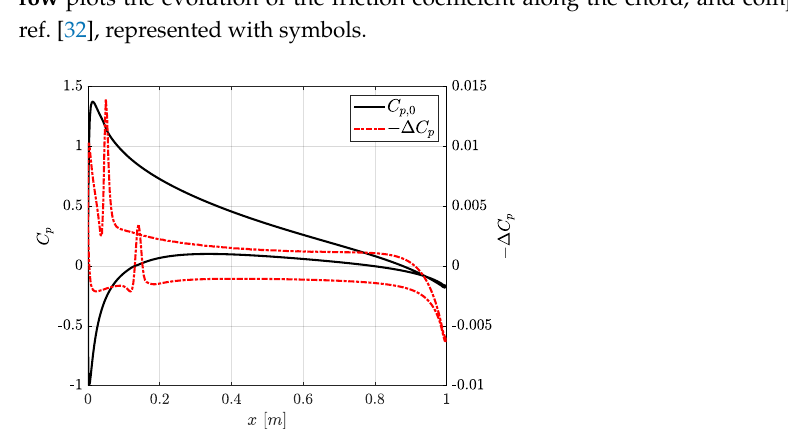
Figure 5. Pressure coefficient on the pressure and suction sides of the NACA0012 airfoil at α = 4 ◦ for the clean case (black line), and difference with the riblets case (red dashed